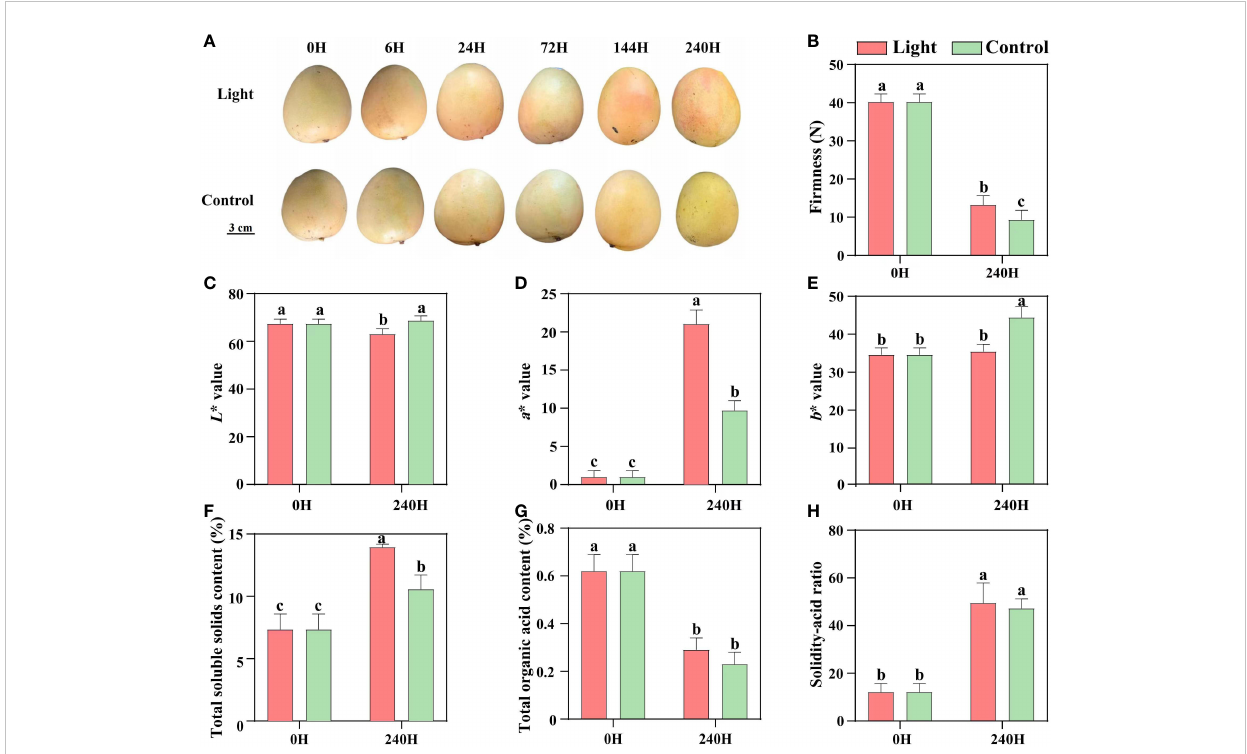
FIGURE 1 Effect of light on the appearance quality and internal quality of ‘ Zill ’ mango. (A) Representative images of light-treated and control (darkness) ‘ Zill ’ mango fruits. (B) Effect of light treatment on fl esh fi rmness. (C – E) Effect of light treatment on fruit color indexes L*, a* and b*. (F – H) Effect of light treatment on the total soluble solids content, total organic acid content and solidity-acid ratio in mango fl esh. Each value represents the mean ± standard deviation of three biological replicates. Values without the same letter are signi fi cantly different, p < 0.05 according to Tukey